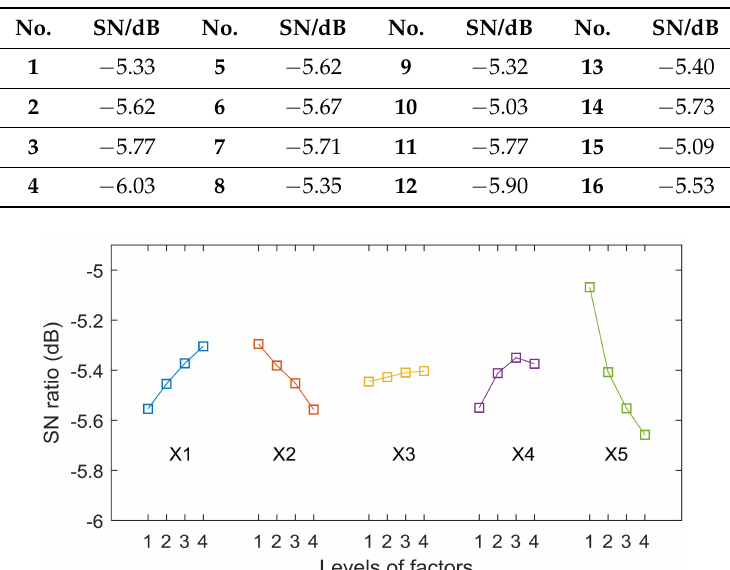
Table 9. S/N ratios of the objective for the 16 experiments of the control factors.